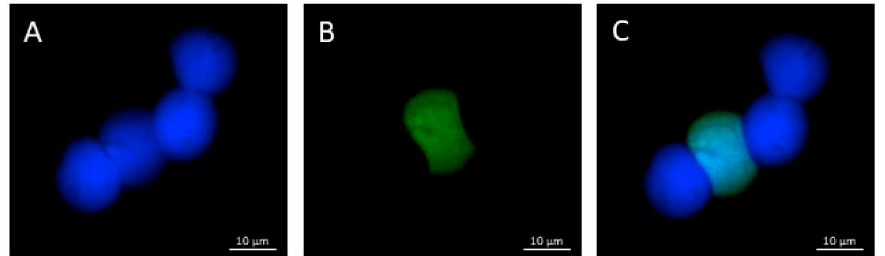
Figure 4. DNA fragmentation in zebrafish blood cells co-exposed to TiO 2 NPs and lincomycin analyzed under a fluorescence microscope (Nikon Eclipse E-600) with different filters. ( A ) DAPI filter, which allows us to observe the nuclei (blue fluorescence); ( B ) fluorescein filter, which allows us to observe the nuclei with fragmented DNA (green fluorescence); ( C ) merged fluorescence image: the DAPI filter and the fluorescein filter